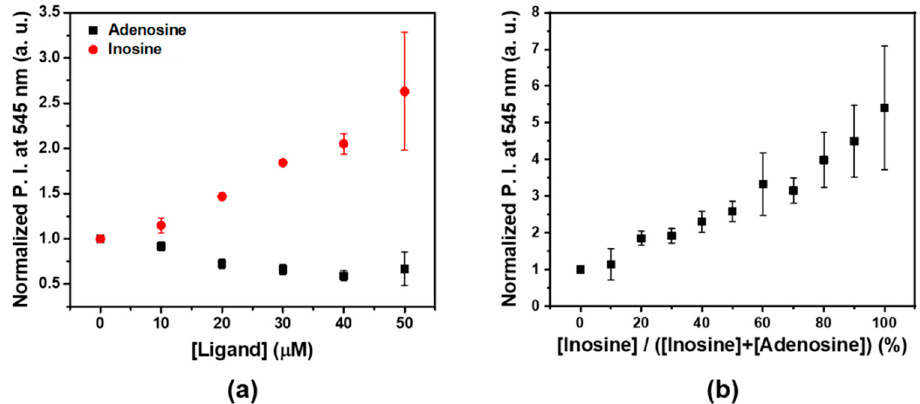
Figure 2. ( a ) Phosphorescence intensities at 545 nm of Tb 3+ (1 mM)-nucleoside (adenosine or inosine) complex upon addition of various concentrations of nucleoside. ( b ) Phosphorescence intensities at 545 nm of Tb 3+ (1 mM)-nucleoside complex in presence of various ratios of inosine/adenosine. λ ex = 260 nm.